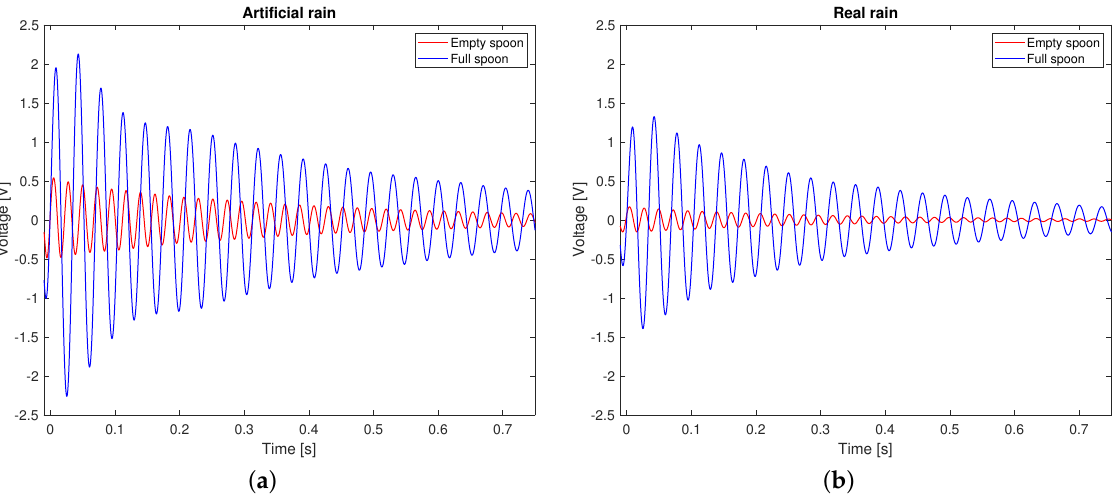
Figure 3. Typical voltage signals obtained from the impact of a drop on the empty and full spoon. ( a ) Indoor tests, ( b ) outdoor tests. The voltage was measured for 3 s from the trigger (0.05 V), with a sampling frequency of 2